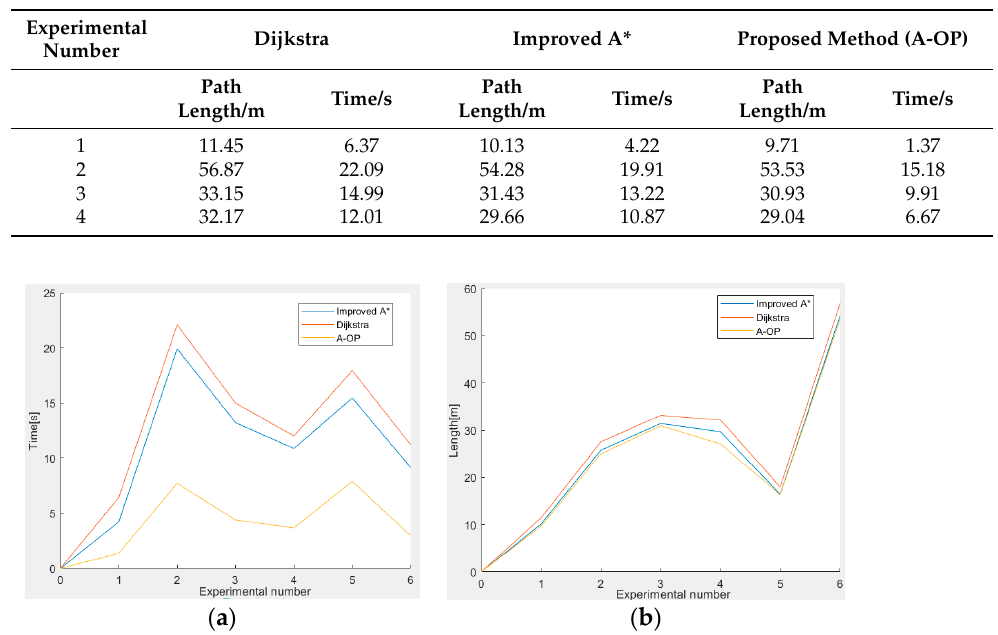
Figure 15. Obstacle avoidance experiments. Table 3. Comparison of experimental results of the three algorithms.